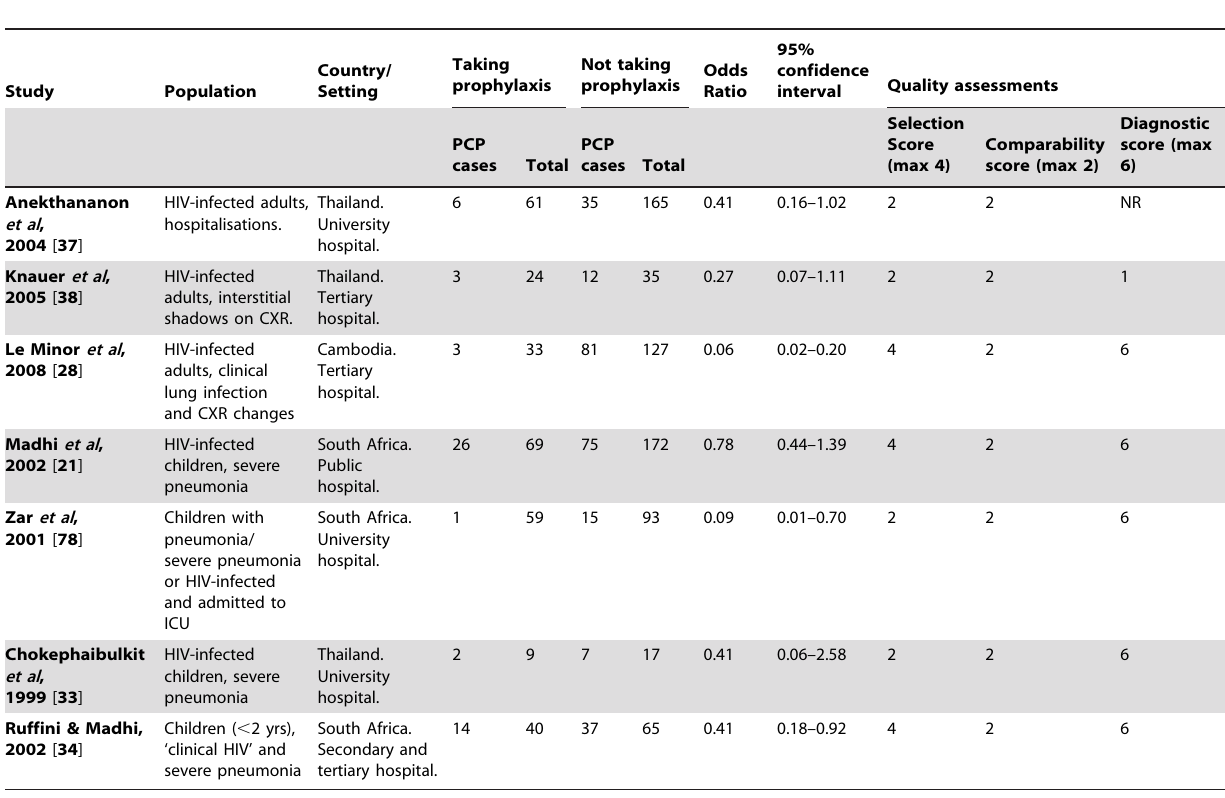
Table 8. Summary of studies detailing effects of prophylaxis on prevalence of